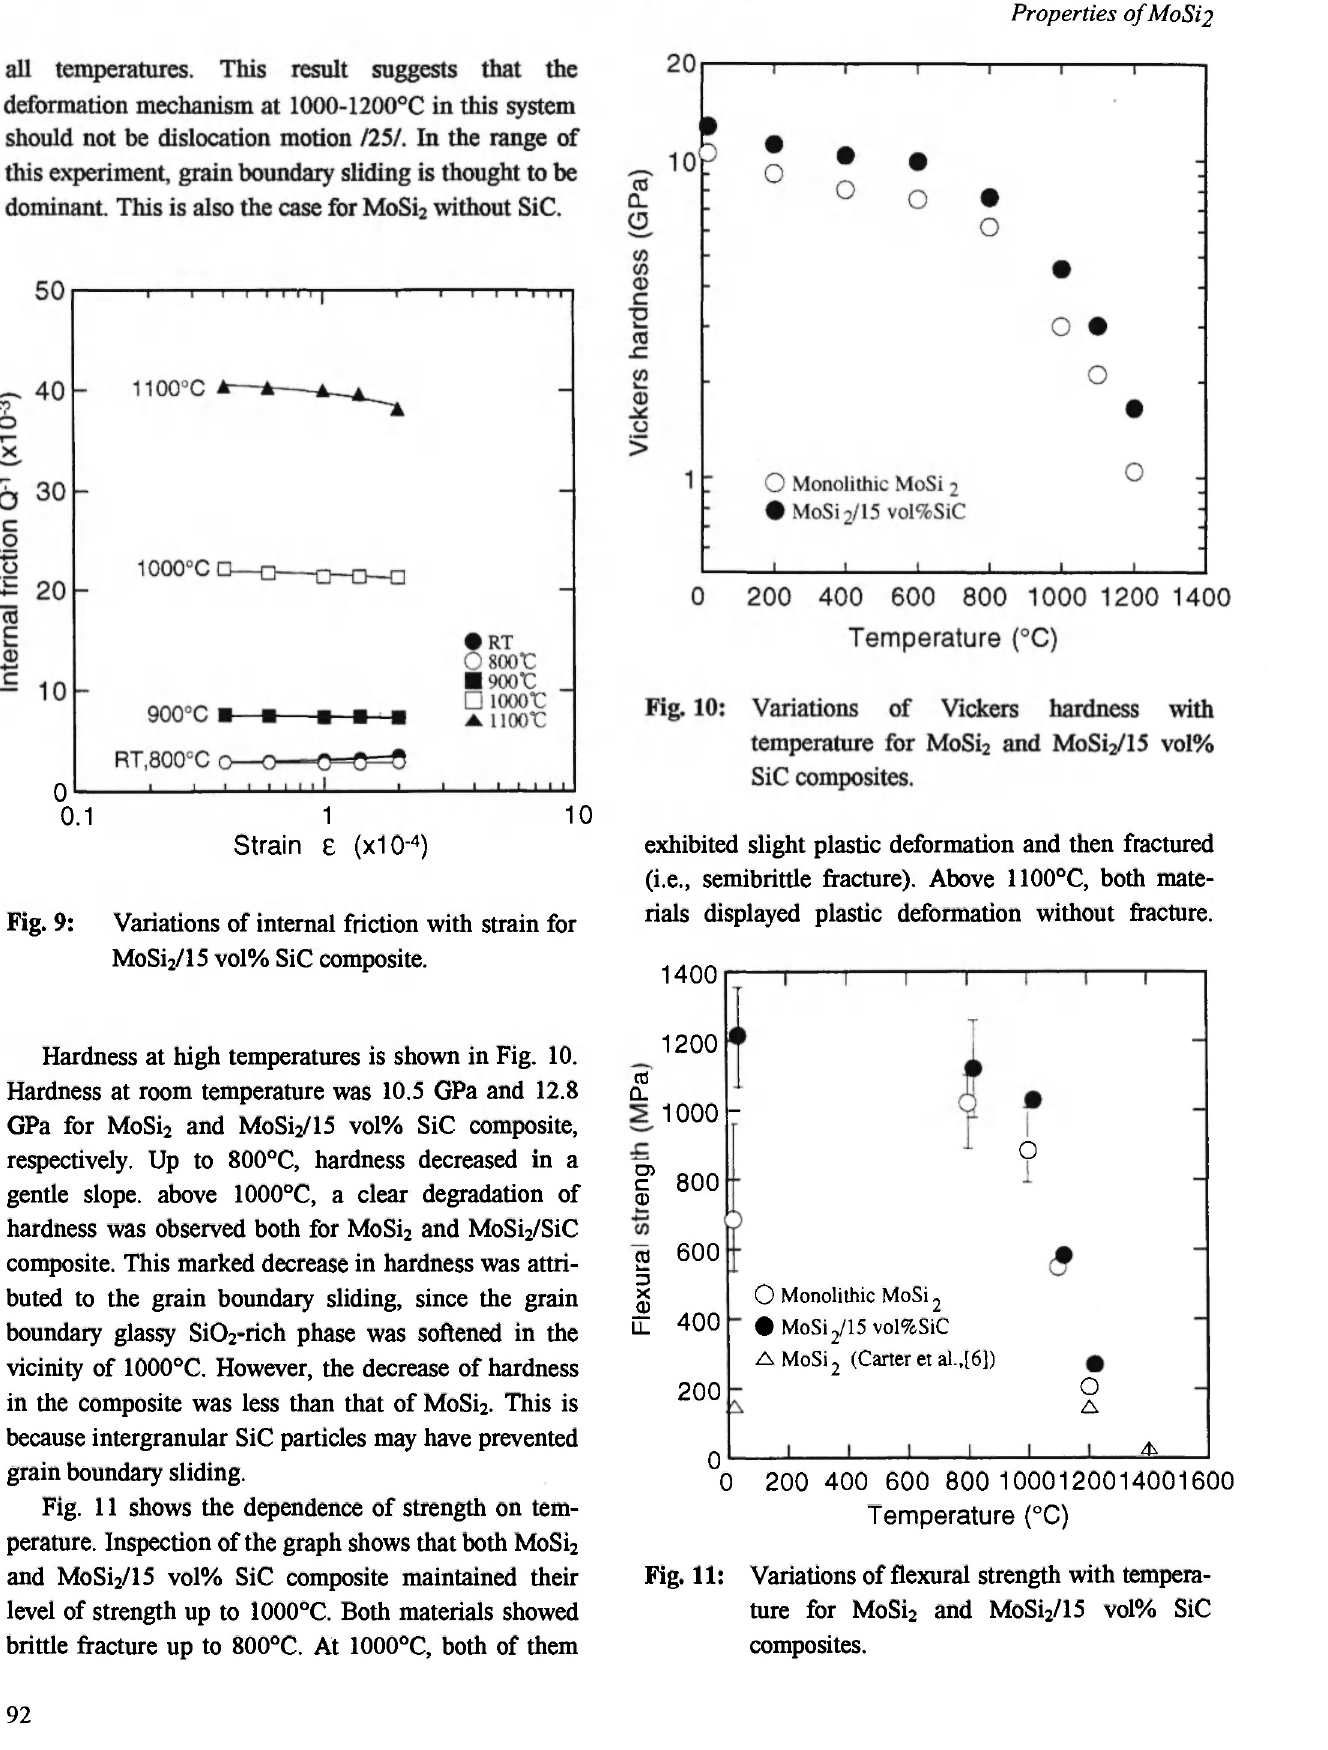
and MoSi /15 vol% SiC 2 2